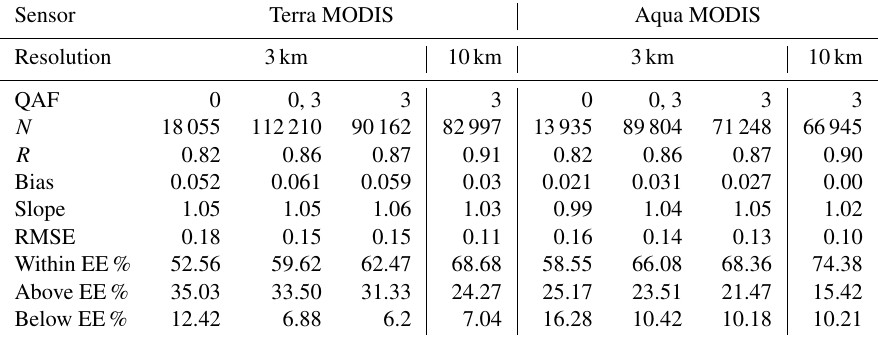
Table 1. Global statistics of comparison between MODIS 3km AOD at 0.55µm retrievals and collocated AERONET observations for both Terra and Aqua, corresponding to three quality assurance categories (QAF = 0 for poor quality, QAF = 0, 3 for all quality, and QAF = 3 for high quality). The data used for the 10km validation do not represent the same time period as 3km. Terra MODIS 10km data period is March 2000 to June 2013 whereas Aqua MODIS 10km data period is January 2003–June 2013. Sensor Terra